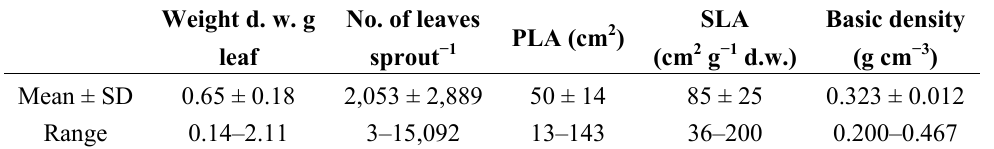
Table 5. Dry weight data for individual leaves (g), total dry weight of leaves per sprout (g), number of leaves per sprout, projected leaf area (PLA; cm 2 ), specific leaf area (SLA; cm 2 g − 1 ) and basic density (g cm − 3 ) for sample sprouts. All values quoted are means ± SD; n =10. Weight d. w.